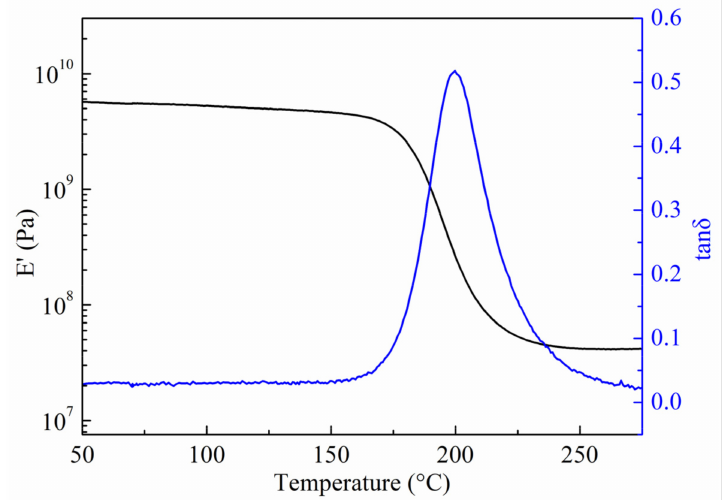
Figure 5. Storage modulus (E’) and tan δ of the matrix resin obtained from DMA method.